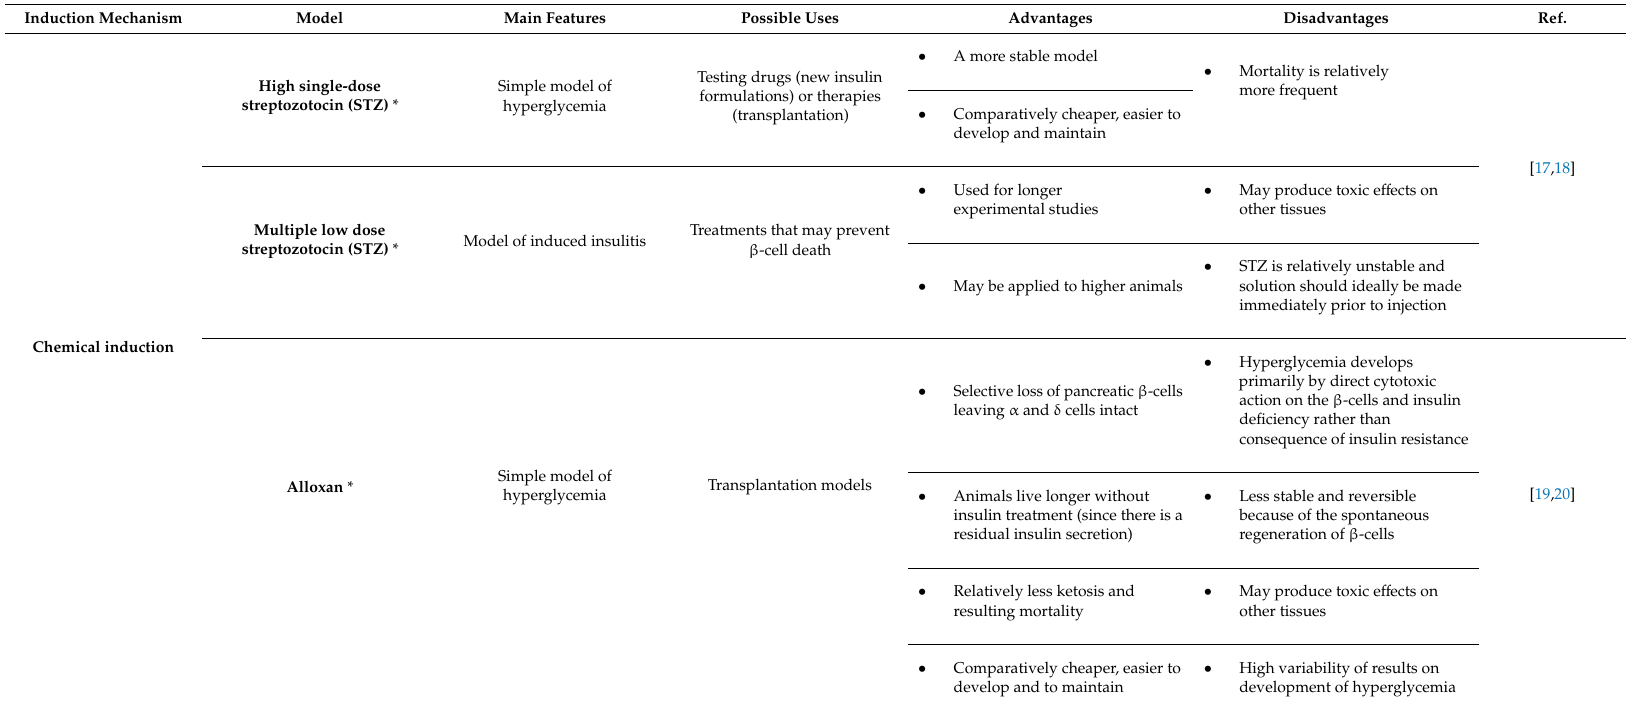
Table 1. Animal models most commonly used to study type 1 diabetes